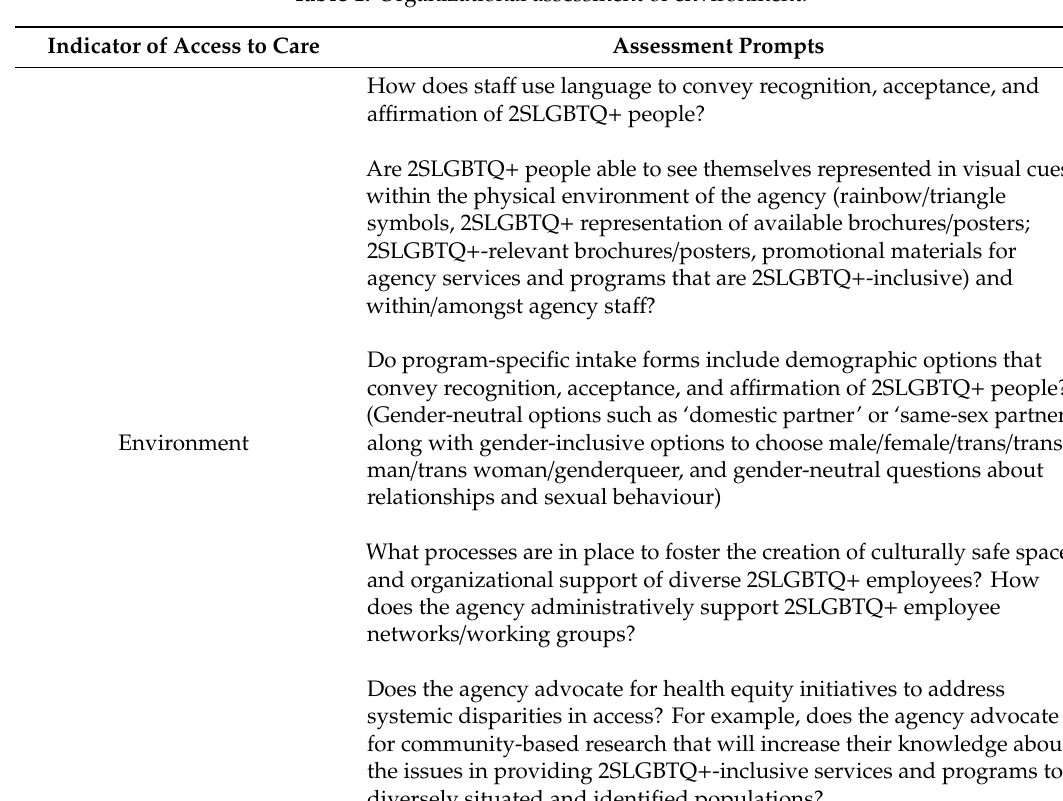
Table 1. Organizational assessment of